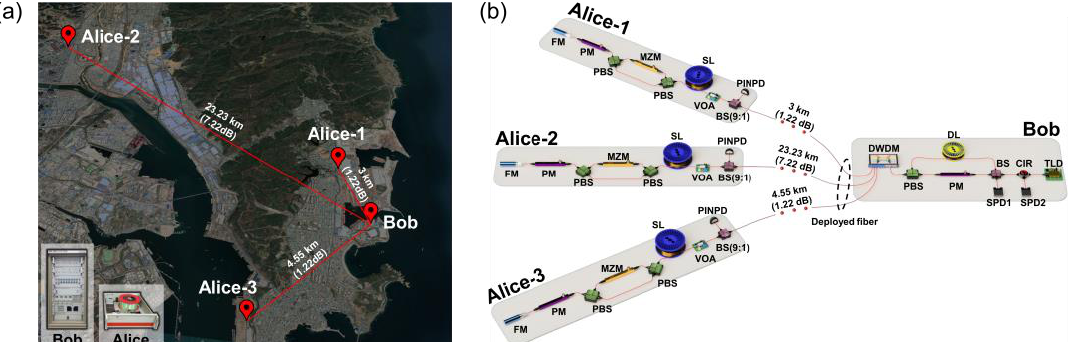
Figure 3. Field deployment and experimental setup of the 1 × 3 quantum key distribution (QKD) network system: ( a ) Field deployment in a smart factory in South Korea. Map data: Google, © 2022 Maxar Technologies, TerraMetrics. The insets show the equipment for the transmitter (Alice) and receiver (Bob); ( b ) Experimental setup. Time- and wavelength-division multiplexing were used to establish the 1 × 3 network. The lengths (in km) and losses (in dB) of the quantum channels were indicated. The abbreviations are defined as follows: tunable laser driver (TLD); circulator (CIR); beam splitter (BS); single-photon detector (SPD); phase modulator (PM); delay line (DL); polariza- tion beam splitter (PBS); dense wavelength division multiplexer (DWDM); p-i-n photodiode